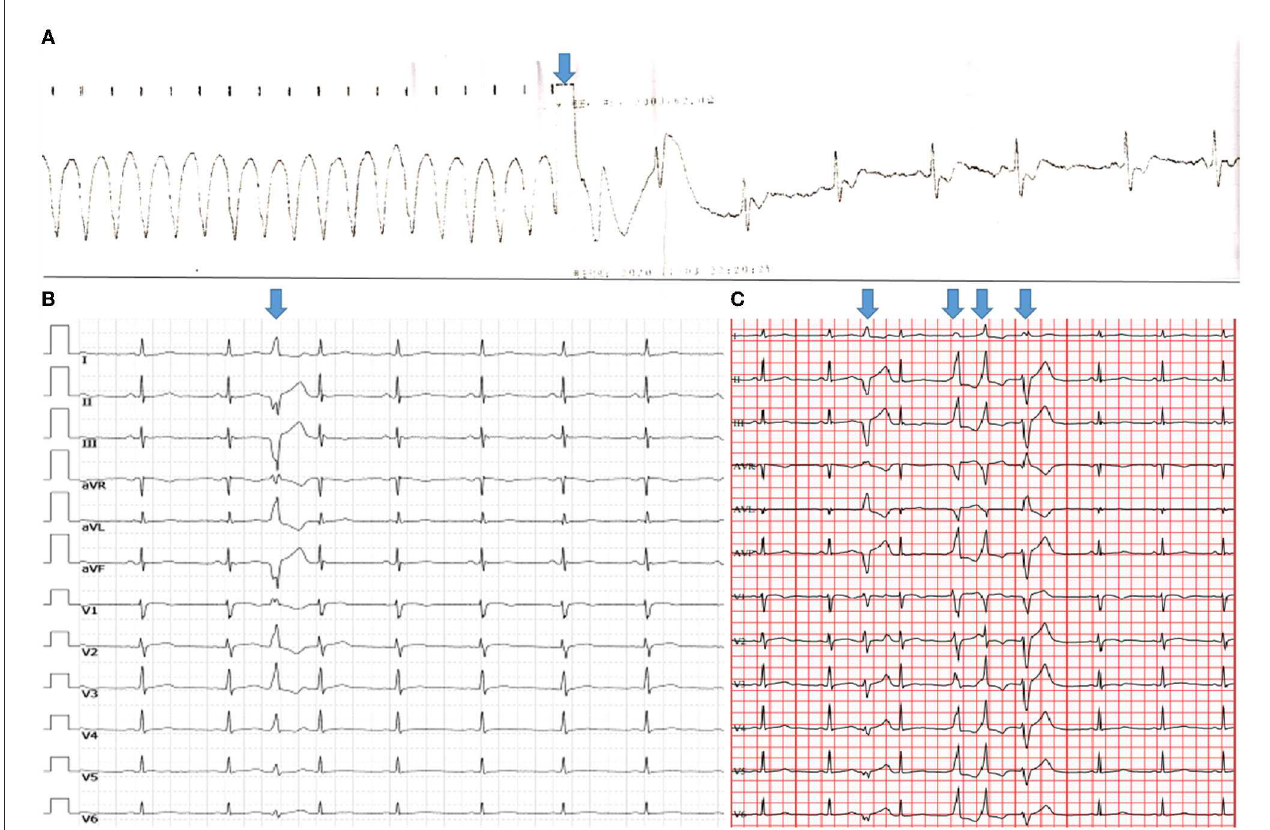
FIGURE1 Ventricular arrhythmias. The height and weight of the patient were 170cm and 55kg, respectively. (A) Electrocardiography revealed that synchronized cardioversion restored ventricular tachycardia to sinus arrhythmia (arrow). (B) A 12-lead standard electrocardiogram revealed relatively low QRS-complex voltage at all leads, as well as a single PVC with RBBB morphology and a superior axis, indicating that the PVC originated in the left ventricle. (C) Holter demonstrated various morphological singles and triplets of PVC (arrows) that may have originated from different